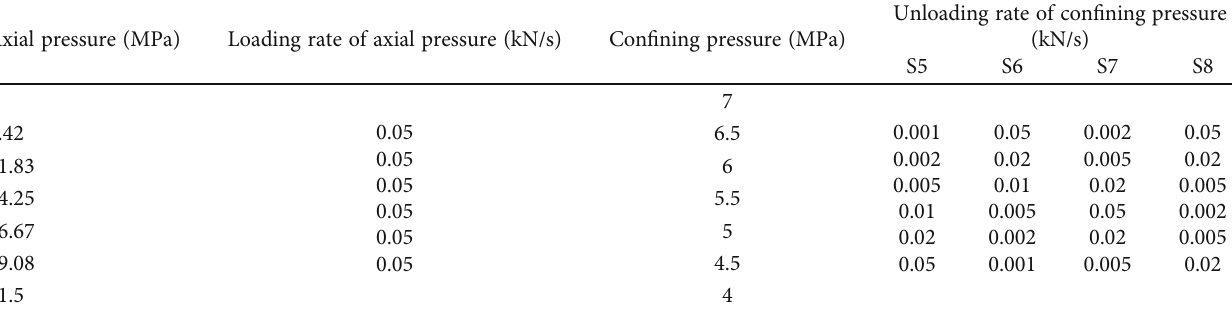
(b) Variable con fi ning pressure unloading rate path (specimens S5-S8)